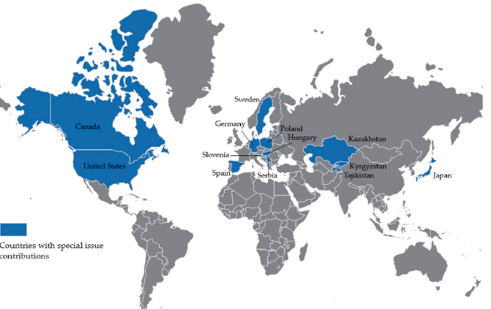
Figure 1. Countries with manuscript contributions in the Special Issue on the Growth and Development of Short-Rotation Woody Crops for Rural and Urban